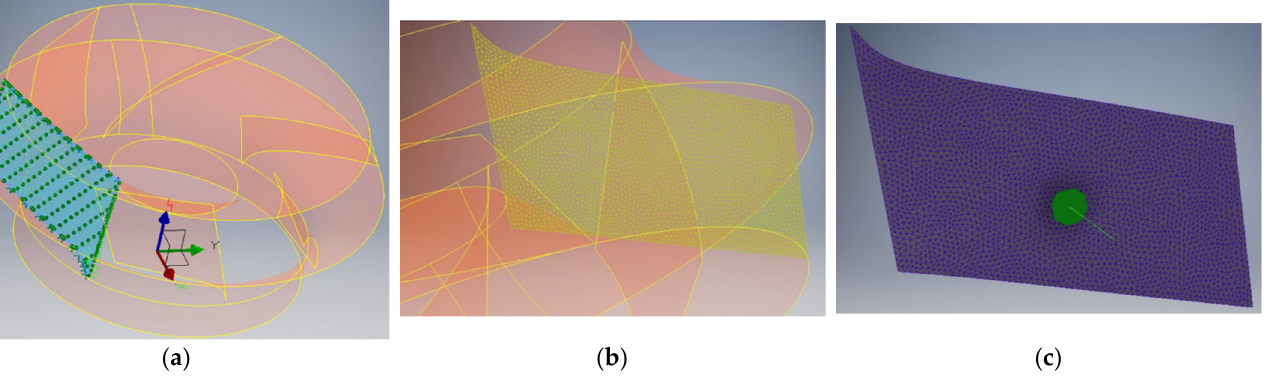
Figure 6. FEA analysis configurations for the stresses and deformations evaluation on a single blade of the impeller: ( a ) shell-type idealization, ( b ) meshing with a characteristic size of 1 mm of the triangular element of the grid, and ( c ) pressure load application.